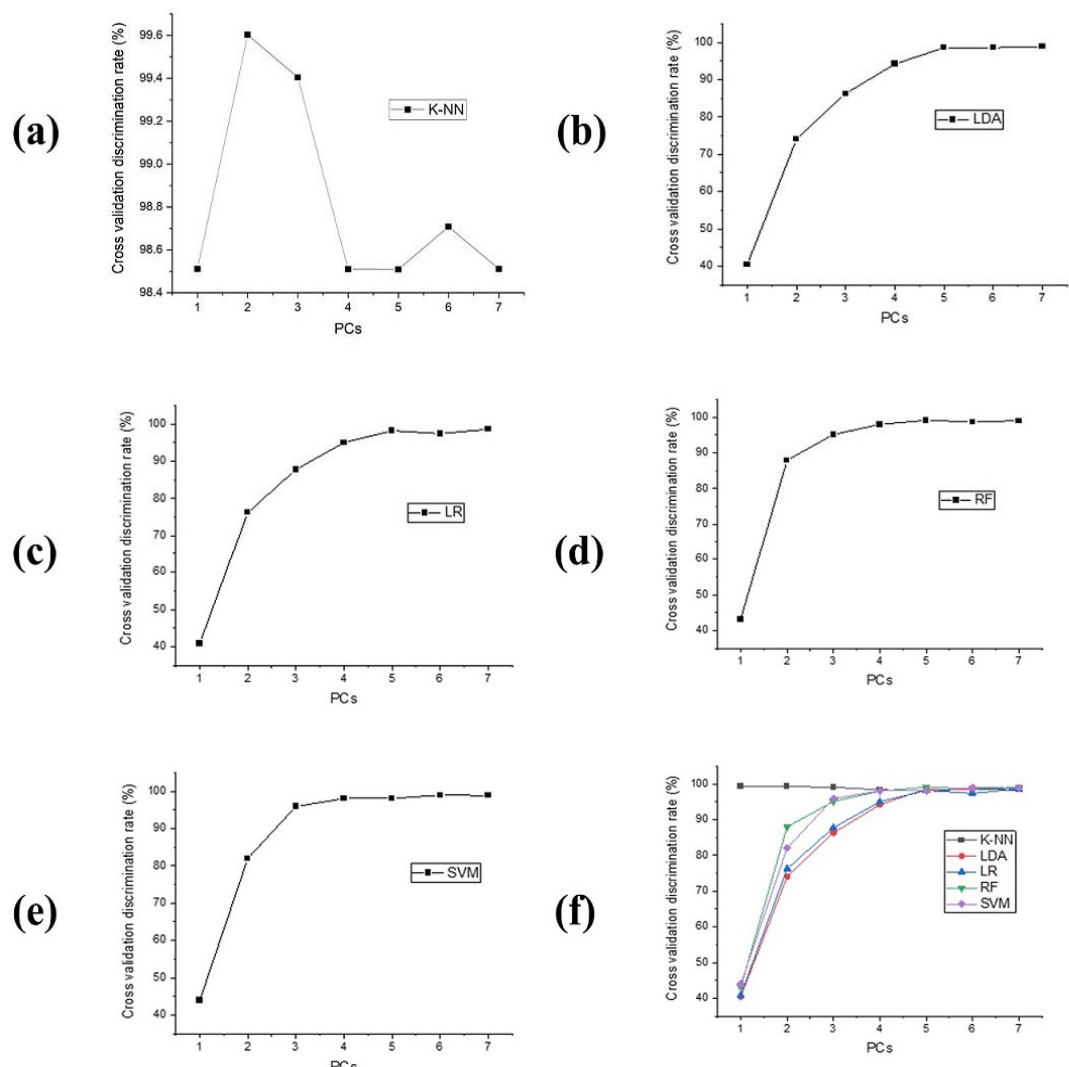
Figure 4. ( a ) Cross-validation discrimination rates of K-NN model at different PCs, ( b ) Cross-validation discrimination rates of LDA model at different PCs at different PCs, ( c ) Cross-validation discrimination rates of LR model at different PCs, ( d ) Cross-validation discrimination rates of RF model at different PCs, ( e ) Cross-validation discrimination rates of SVM model at different PCs, ( f ) Cross-validation discrimination rates of the five models at different PCs.